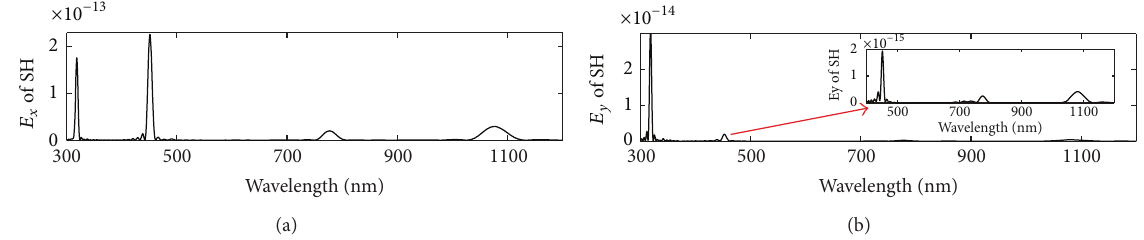
Figure 7: The FTS of second-order nonlinearity signals at the wavelength 318 nm, 451 nm, 774 nm, and 1080 nm for the two continuous wave 𝐸 (1) 𝑦 incidence at the wavelengths